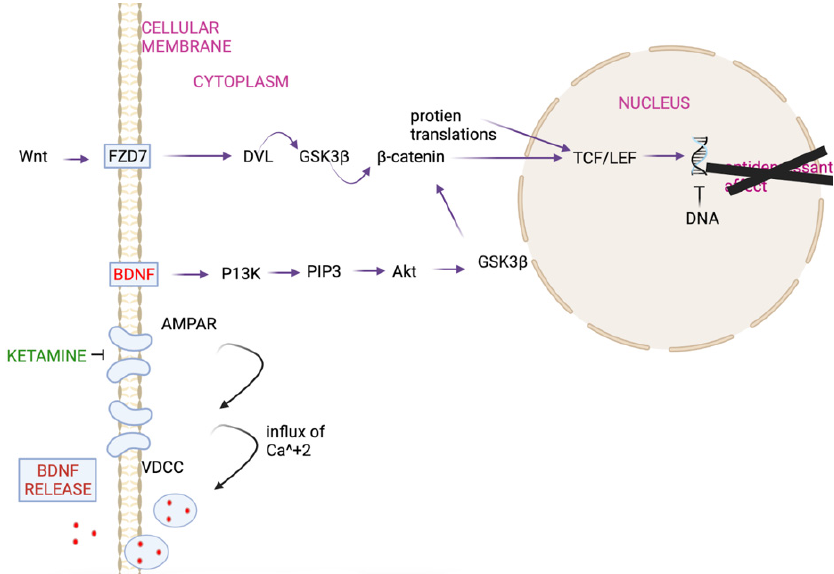
Figure 2. Diagram of the Wingless-related integration site as it functions in a person with Bipolar Disorder with Ketamine as a treatment. The mentioned genes and proteins are: Frizzled homolog 7 (FZD7), Glycogen Synthase Kinase 3 Beta (GSK3B), Beta Catenin (B-catenin), T-cell factor/lymphoid enhancer factor (TCF/LEF), Brain-Derived Neurotrophic Factor (BDNF), Phosphoinositide 3-kinases (P13K), phosphoinositide 3 kinase (PIP3), Protein kinase B (Akt), AMPAR( α -amino-3-hydroxy-5- methyl-4-isoxazolepropionic acid receptor), and VDCC (Voltage-gated calcium channel).